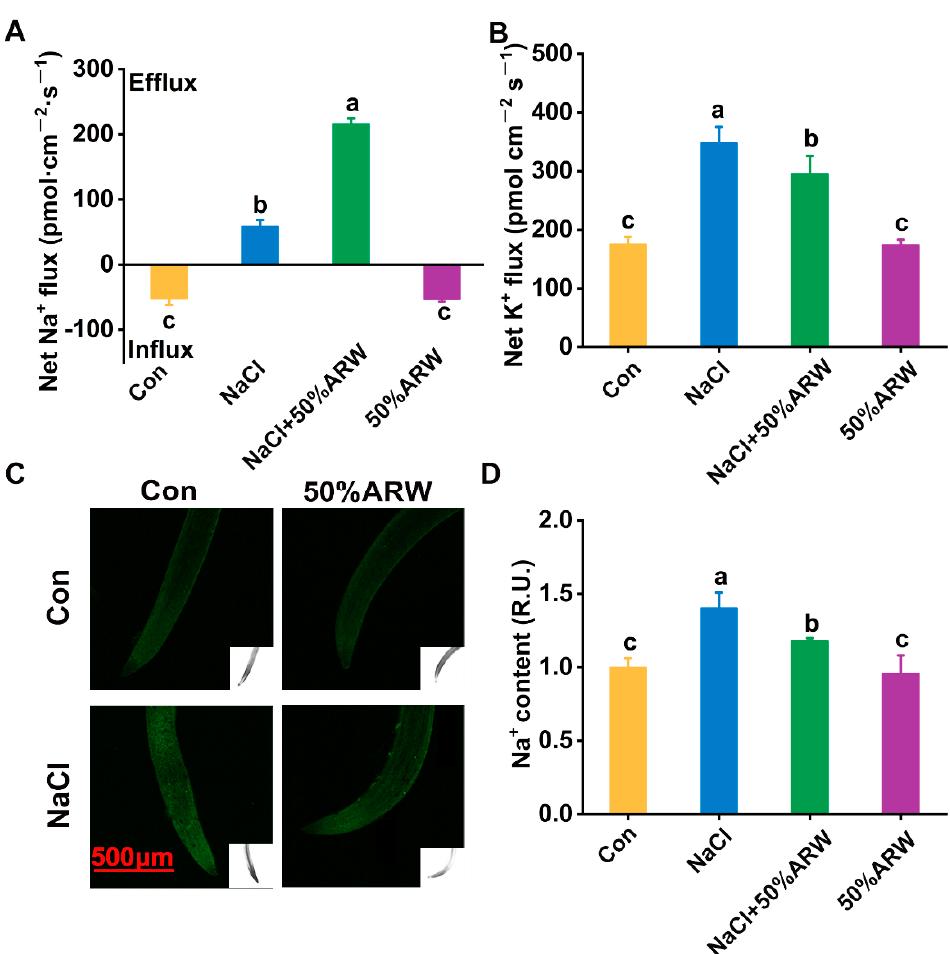
Figure 3. Ion homeostasis was reestablished by argon. After germination for 3 d, net Na + ( A ) and K + fluxes ( B ) in the mature root zone were monitored. Meanwhile, Na + fluorescence ( C ) in the root tips was also determined. Mean relative Na + fluorescence intensities ( D ) corresponding to ( C ) are given. R.U., relative unit. Bar = 500 µ m. The error bars represent the SD ( n = 3; 10–50 samples/treatment/repeat). Bars with different letters (a–c) were significantly different at p < 0.05 according to Duncan’s multiple range test.